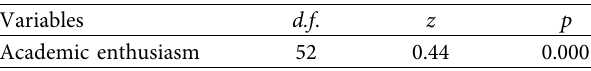
Table 2: Normal distribution.